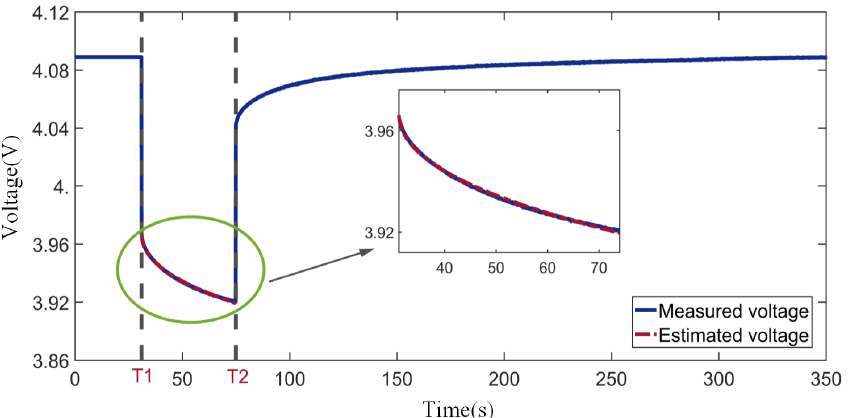
Figure 6. Fitting result of the output voltage of instantaneous discharge at the first cycle number (battery No.